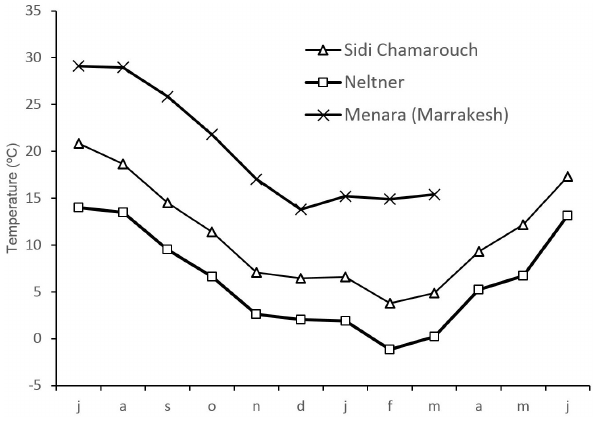
Figure 5. Mean monthly air temperatures from July 2015 to June 2016 in Marrakesh (Menara, 468m) and in Sidi Chamharouch (2370m) and Neltner